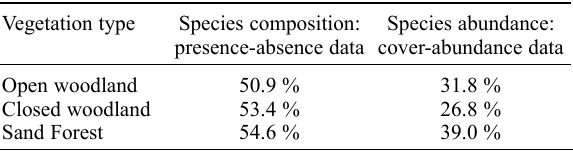
Table 3 A comparison between the vegetation of Tembe Elephant Park and Tshanini Game Reserve by means of the Sorensen Similarity Index based on species composition and that of Motyka et al . ( In : Mueller-Dombois & Ellenberg 1974) based on species abundance Vegetation type Species composition: Species abundance: presence-absence data cover-abundance data Open